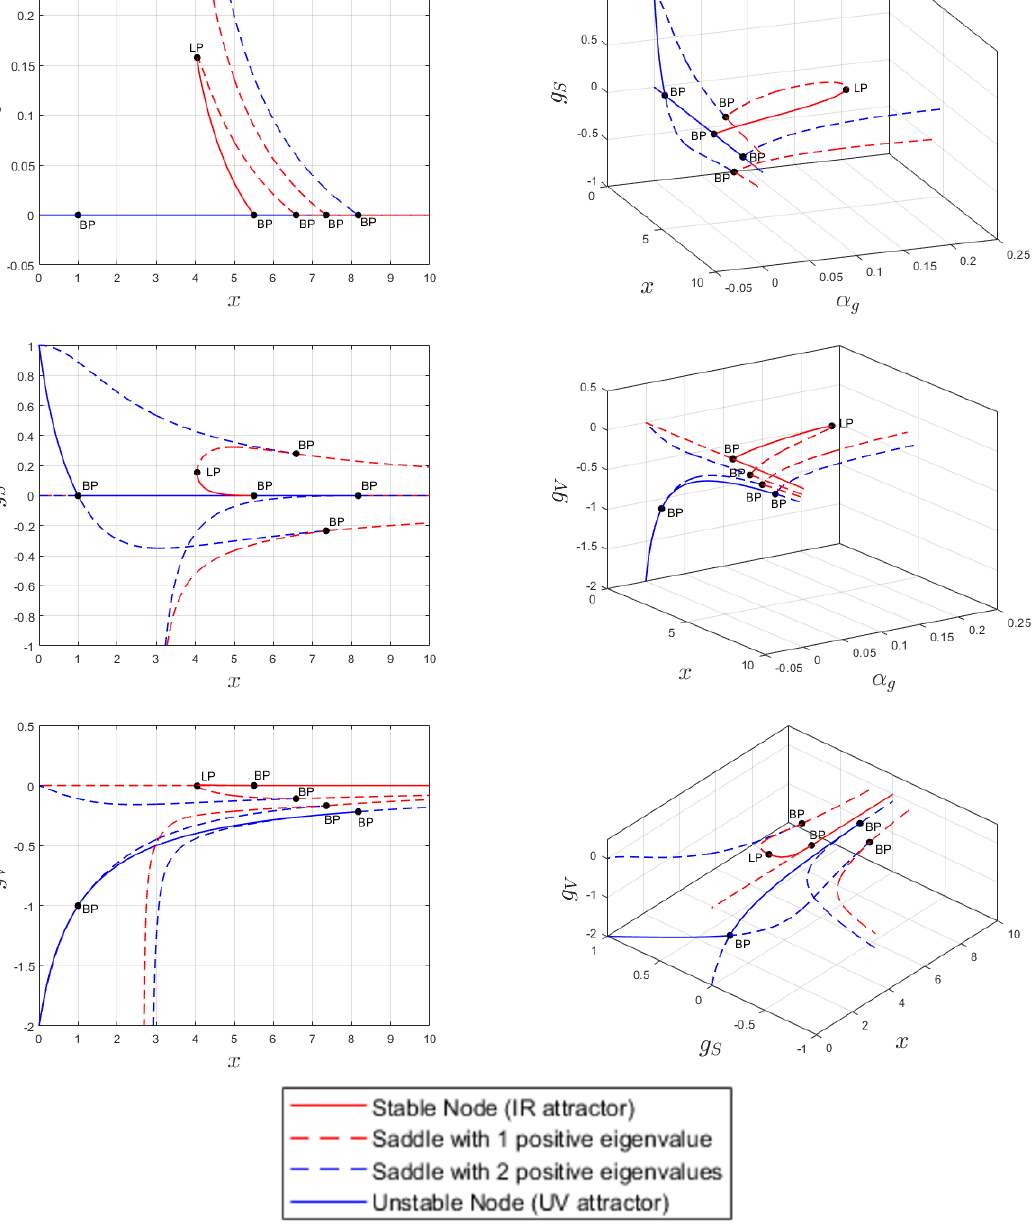
Figure 2. The (cid:12)xed points of the RG-(cid:13)ow of (2.9) projected on the ( x; (cid:11) plane, ( x; g V )-plane, ( x; (cid:11) g ; g S )-space, ( x; (cid:11) g ; g V )-space and the ( x; g S ; g V )-space. LP: Limit Point (Saddle-Node Bifurcation). BP: Branching Point (Transcritical Bifurcation).